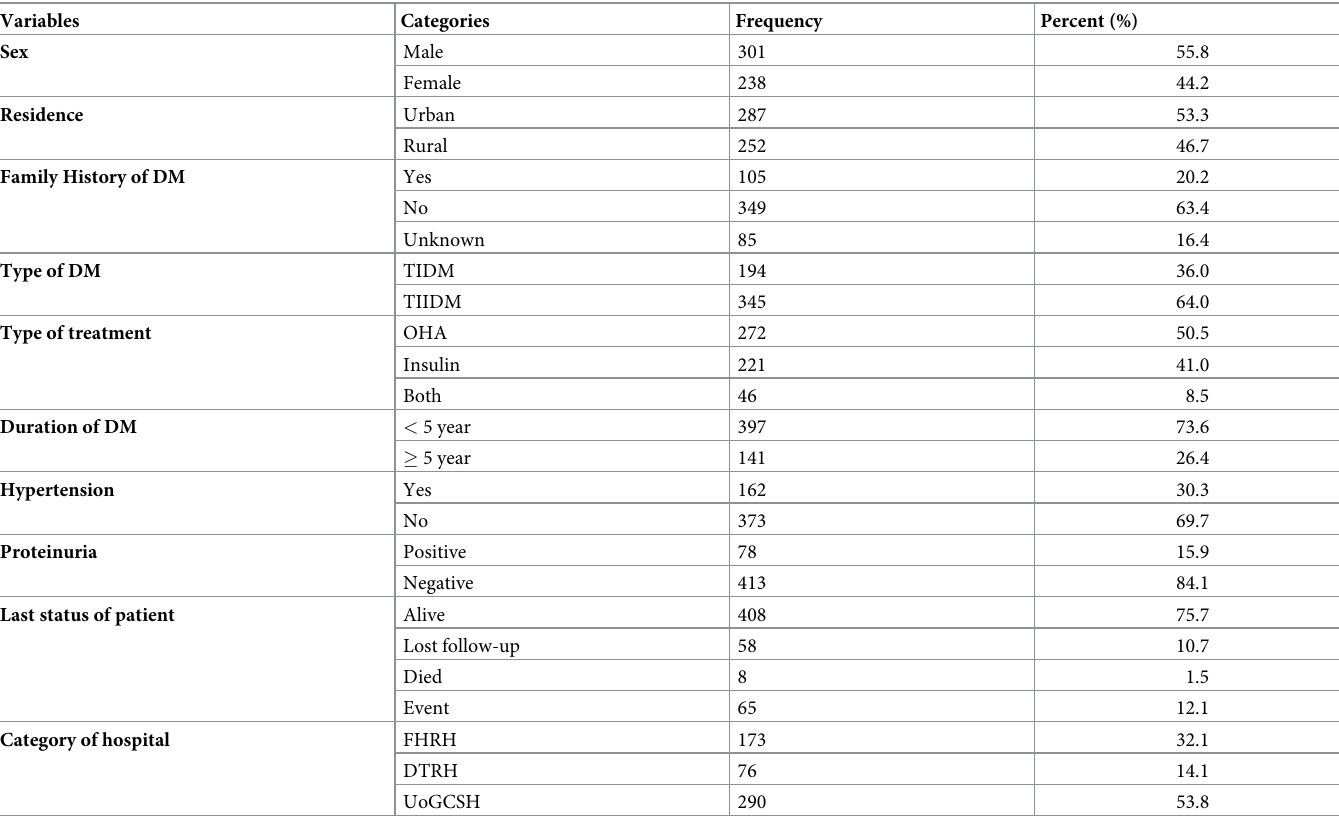
Table 1. Socio-demographic and clinical characteristics of DM patients on treatment at UoGCSH, FRH, DTRH in Northwest Ethiopia, 2010 to